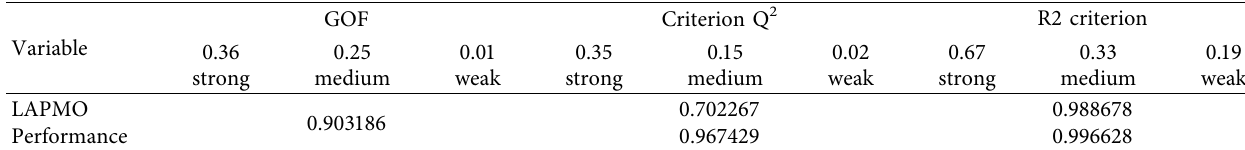
Table 9: Report related to the R2 criterion, Q2 criterion, and GOF criterion